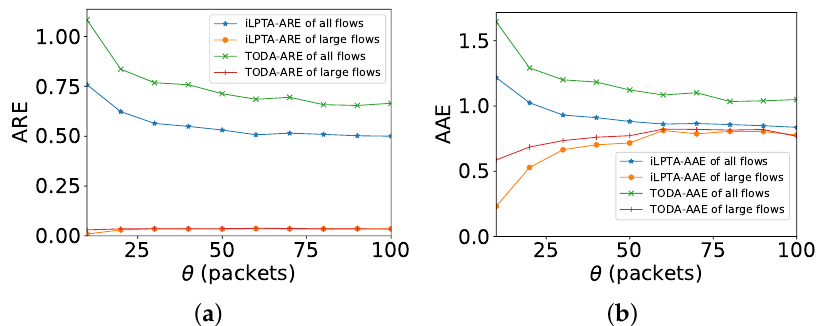
Figure 9. Measurement accuracy with different θ . ( a ) ARE; ( b ) AAE.